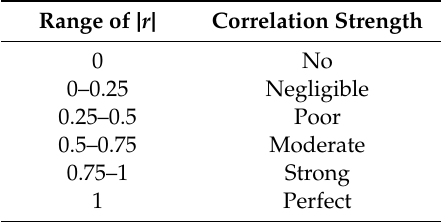
Table 1. Pearson’s correlation coe ffi cients (PCCs) related to the correlation